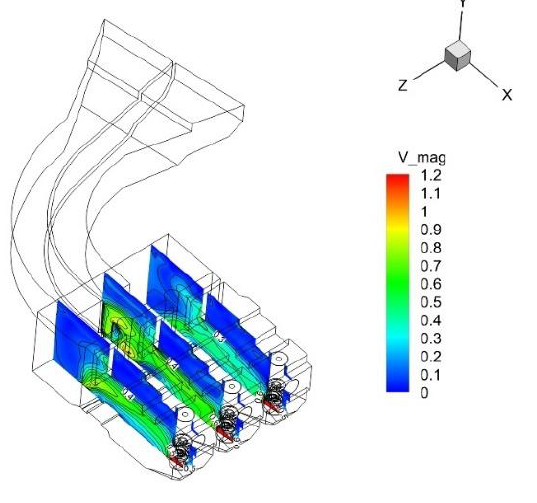
Figure 17. Plan 9 Isogram of velocity. ( a ) Center section of pump body along flow direction. ( b ) Center section of pump body in vertical flow direction.